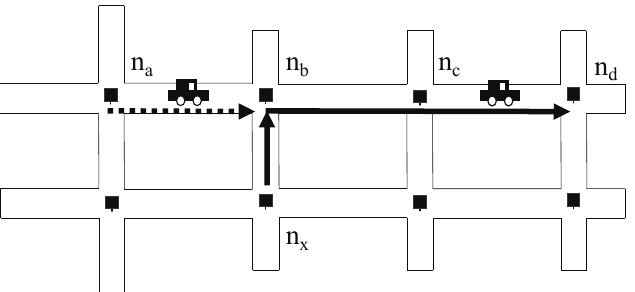
Figure 9. Illustration on computing delay metrics: The delay metric from n b to n d is computed as the sum of the waiting delay at n b and the transportation delays on ( n b , n c ) and ( n c , n d )